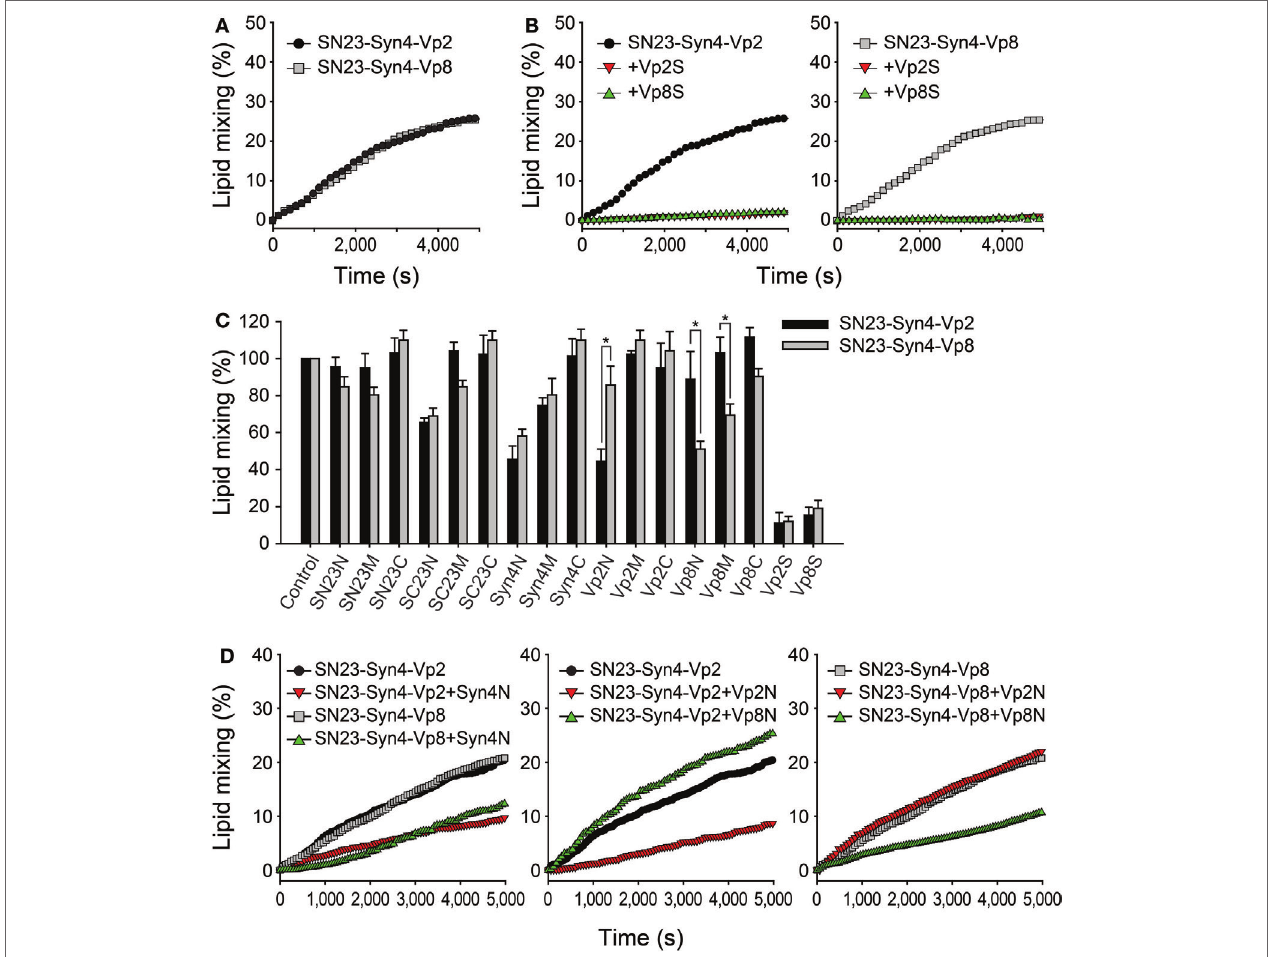
FigUre 3 | Inhibitory effects of the synthetic peptides on SNARE-driven membrane fusion. (a) Lipid mixing assay of T-liposomes containing syntaxin 4 (Syn4) and SN23 together with V-liposomes prepared with Vp2 (black) or Vp8 (gray). The assay was monitored by measuring the dequenching of NBD fluorescence and the data were plotted as a function of time. The maximum NBD signal was obtained by adding 0.1% Triton X-100 ™ . (b) The soluble N-ethylmaleimide-sensitive factor attachment protein receptor (SNARE)-mediated membrane fusion was completely blocked by the cytoplasmic domains of Vp2 (Vp2S, red) and Vp8 (Vp8S, green) at the concentration of 10 µM. (c) The inhibitory effects of synthetic peptides on lipid mixing using mast cell SNAREs including Vp2 (black) and Vp8 (gray). Each bar represents the mean ± SD of three independent experiments. The statistical significance of differences was evaluated by analysis of variance (* p < 0.05). (D) The curves represent the lipid mixing driven by SN23-Syn4-Vp2 or SN23-Syn4-Vp8 in the presence of the most effective peptides (Syn4N, Vp2N, and